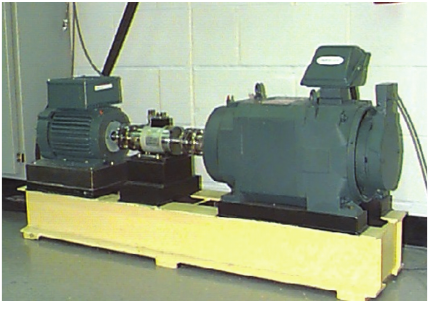
Figure 5: The experimental bench.